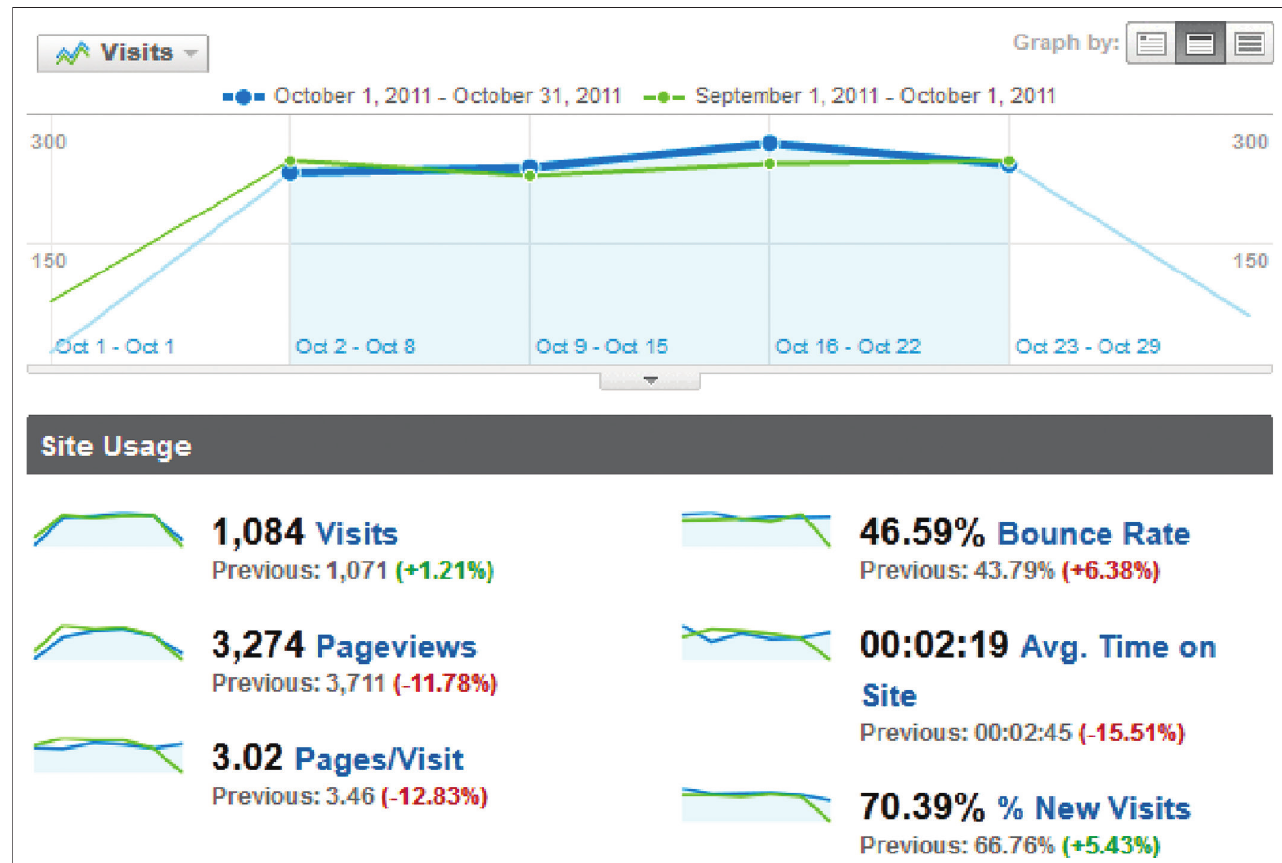
FIGURE 5: Total Traffic October 2011 compared to September